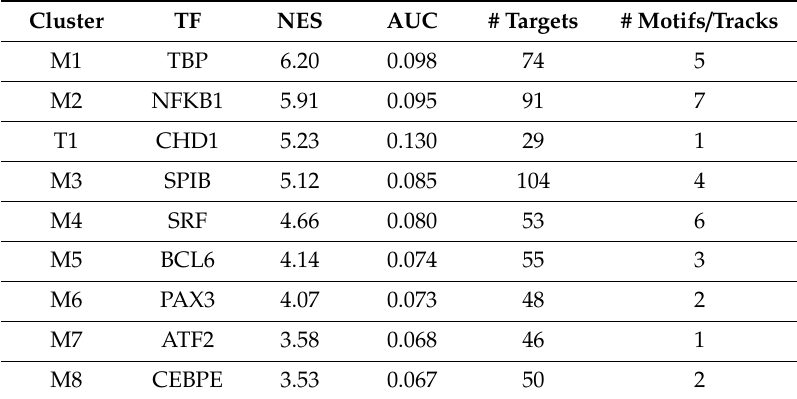
Table 1. Summary of enriched motifs and tracks aggregated in